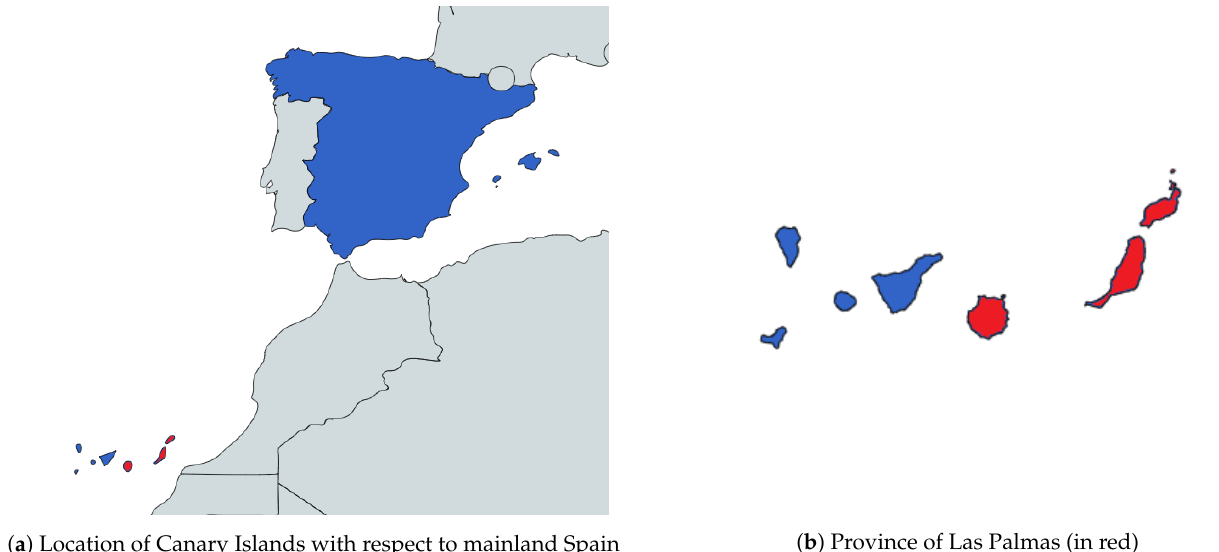
Figure 1. Location of Canary